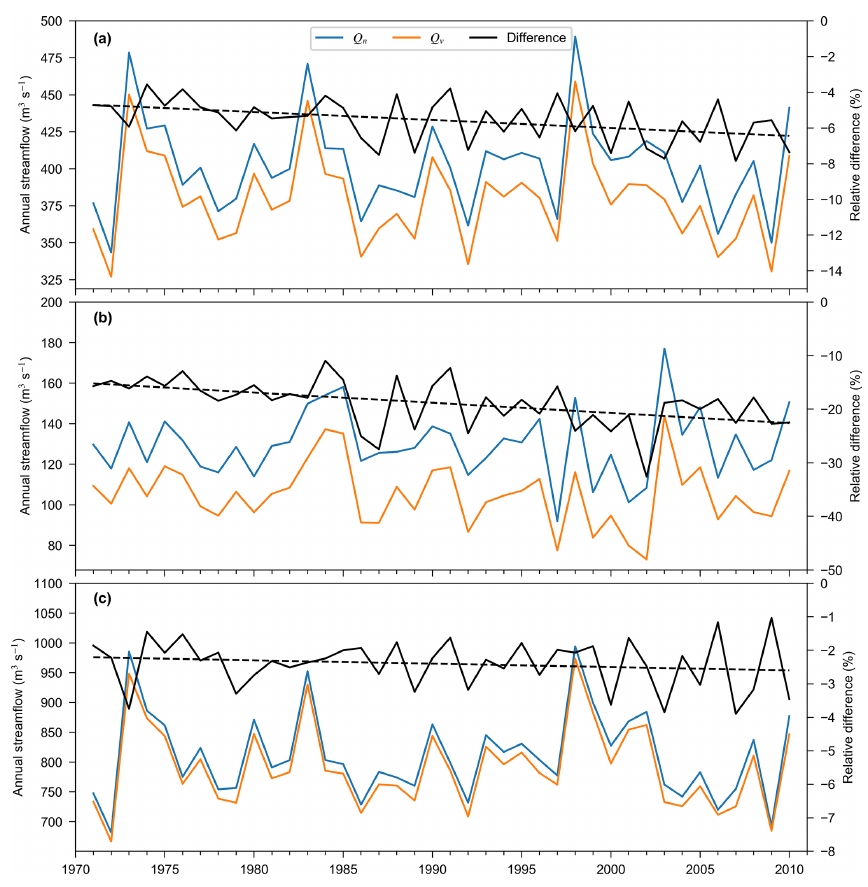
Figure 3. Spatially averaged annual streamflows (m 3 s − 1 ) from NOSOC and VARSOC experiments and their differences (%) during the 1971–2010 period. (a) Average of ensemble medians of annual streamflow from NOSOC ( Q n ) and VARSOC ( Q v ) for China, (b) for the northern basins, and (c) for the southern basins. The northern and southern basins are described in Fig. 1. The dashed lines denote the linear trend of the relative